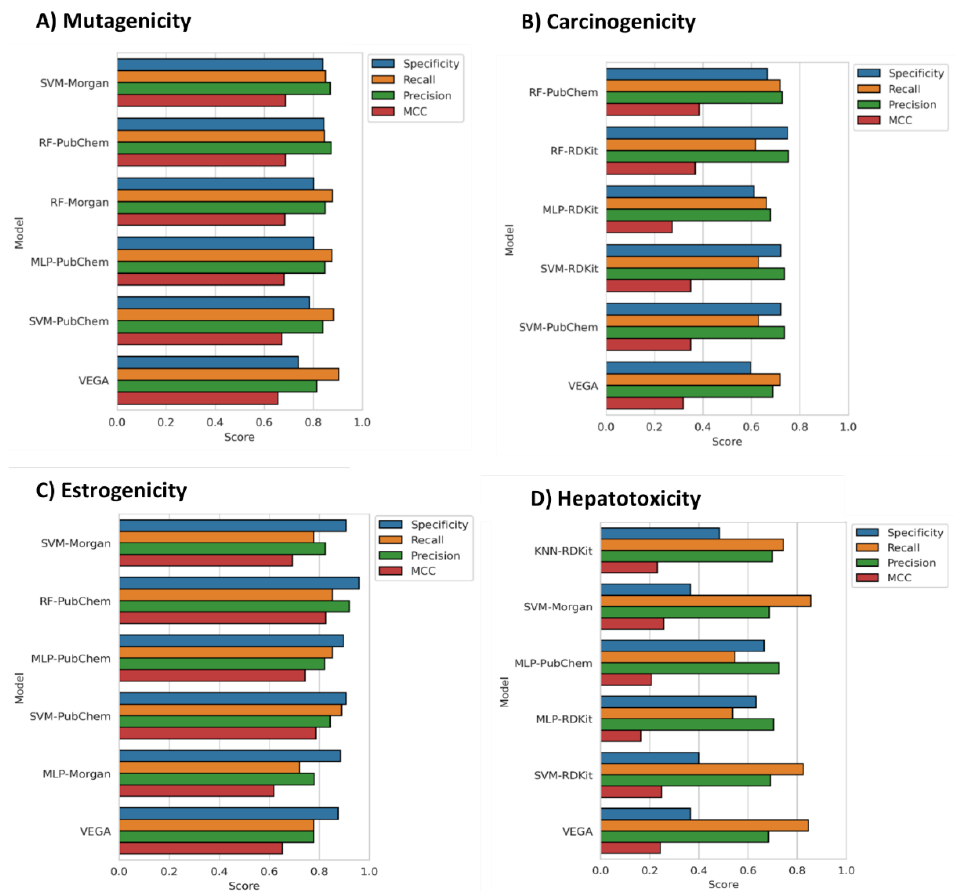
Figure 2. Performance evaluation results, based on test set prediction, obtained for the 5 top-scored models of the ( A ) mutagenicity, ( B ) carcinogenicity, ( C ) estrogenicity and ( D ) hepatotoxicity endpoint, in comparison with the reference models included in VEGA.